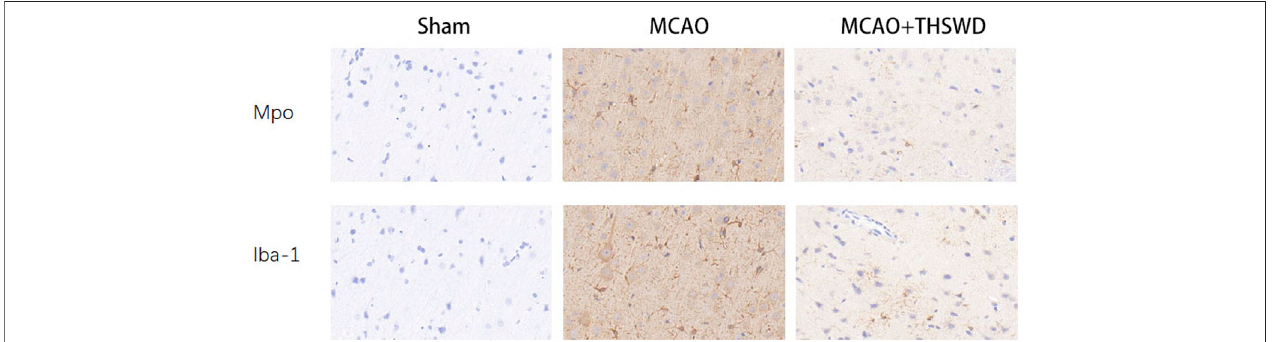
FIGURE 7 | Expression of microglia and neutrophils in each group.